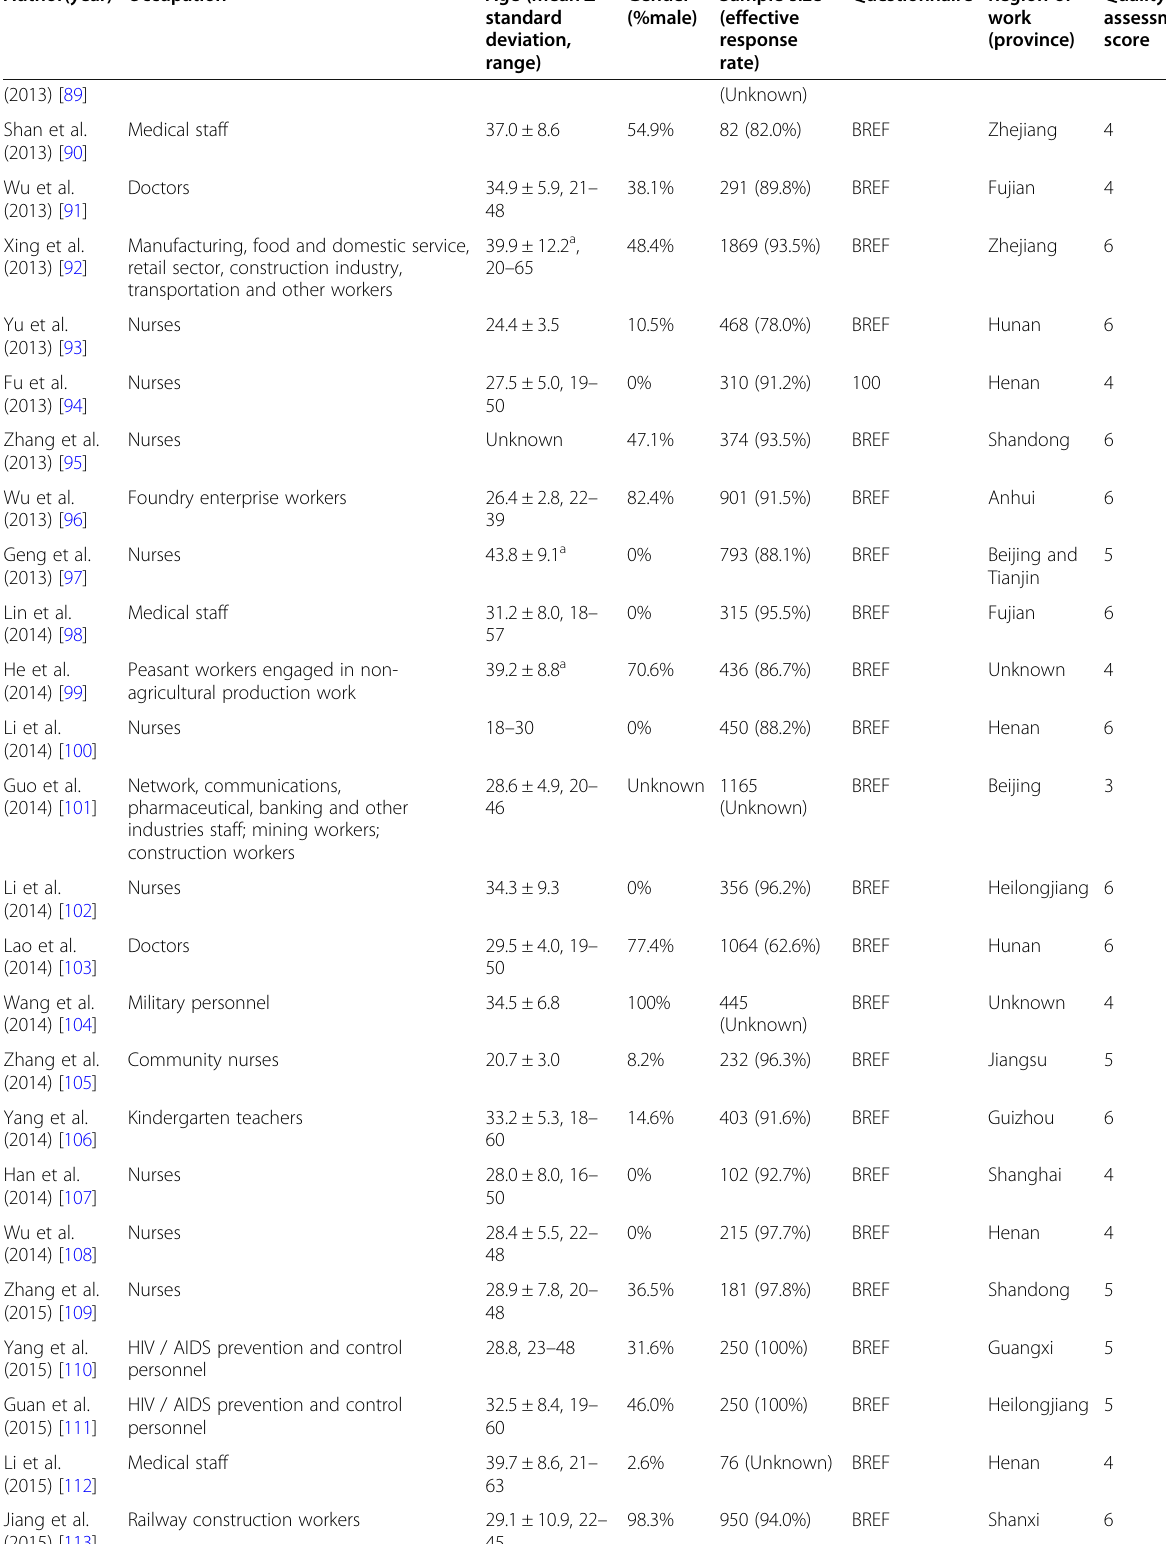
Table 2 Descriptive characteristics and quality assessment of the included publications